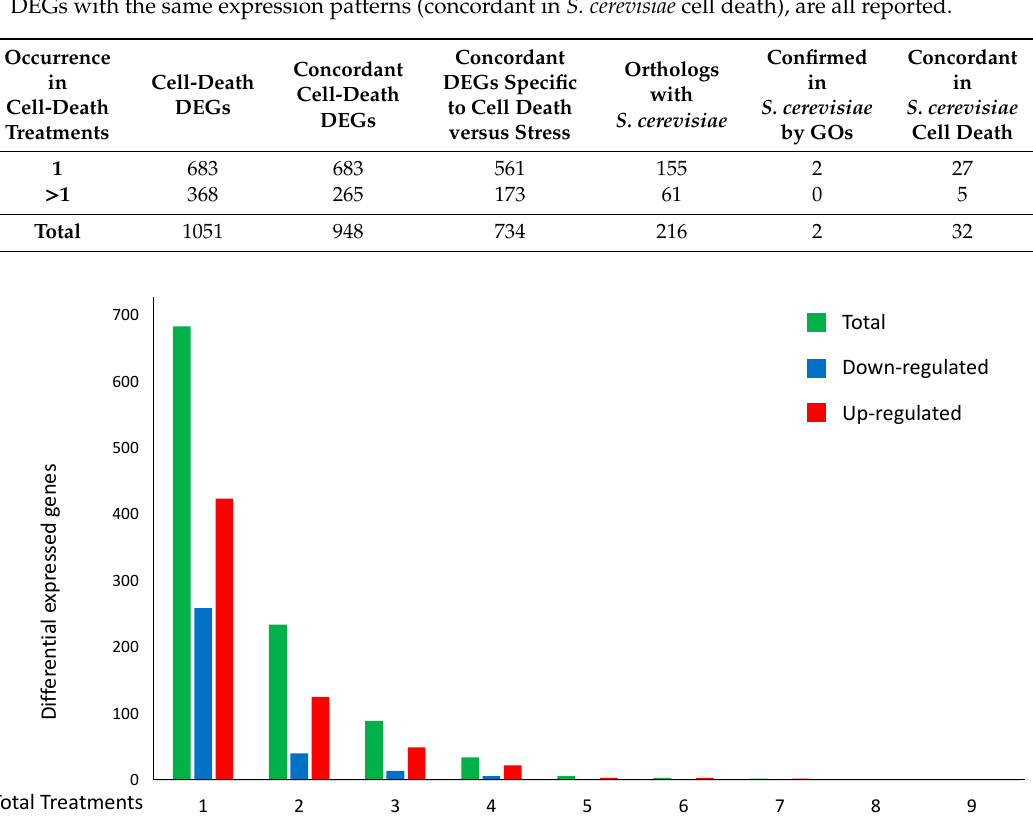
Figure 3. Distributions of the number of DEGs per number of H. sapiens cell-death-related experiments. The histogram represents the total number of DEGs (green) for cell-death treatments. The number of up-regulated (red) and down-regulated (blue) DEGs with the same expression pattern are also reported.